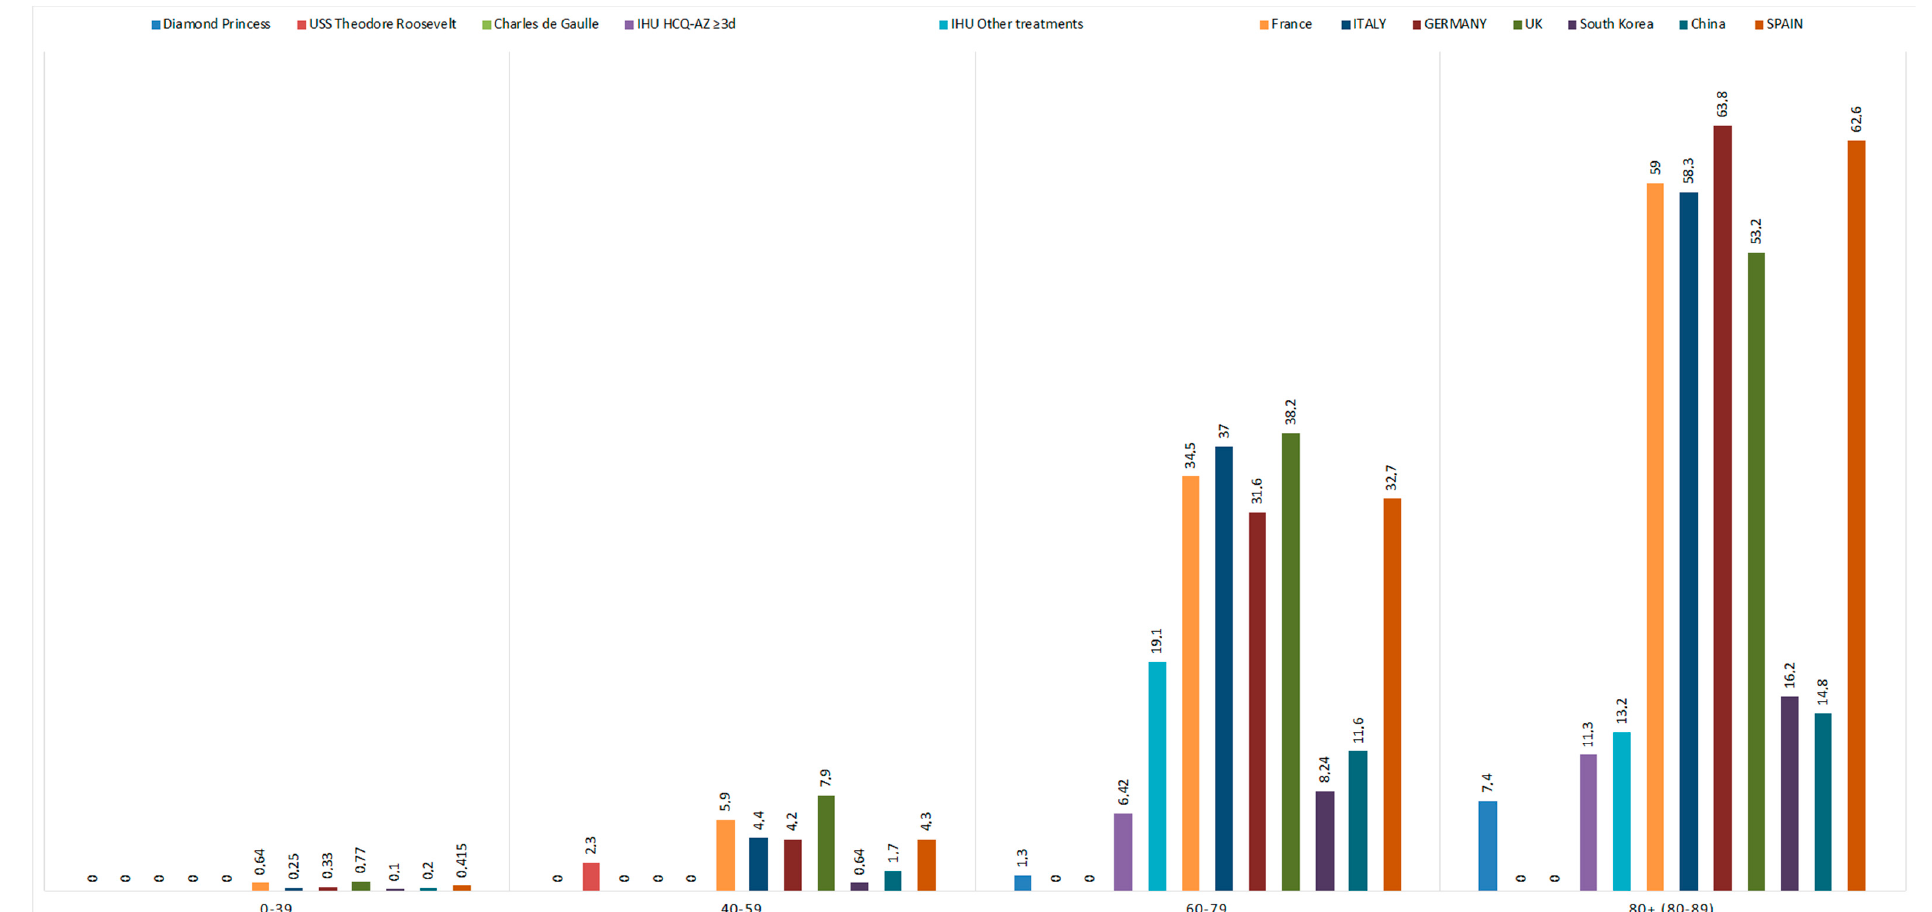
Figure 1. Mortality rate by age group on 3 ships (the Diamond Princess, the USS Theodore Roosevelt and the Charles de Gaulle) and in France, Italy, Germany, the United Kingdom (UK), Korea, China, Spain and our institute following treatment (hydroxychloroquine and azithromycin or other) [27].